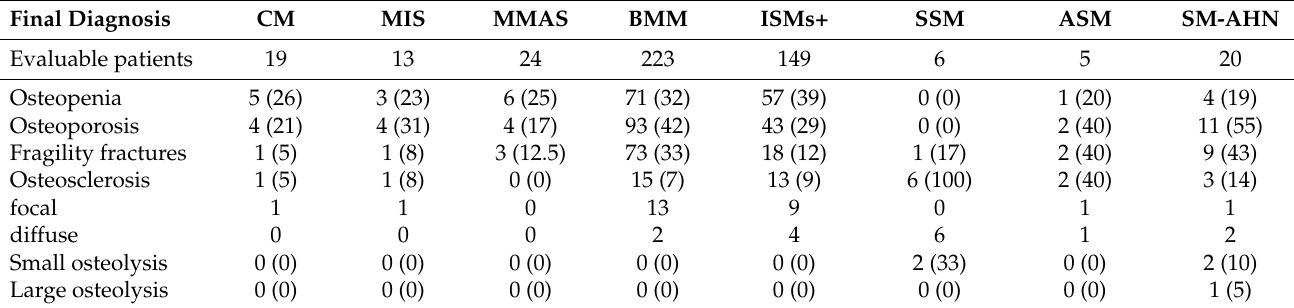
Table 5. Bone involvement in patients according to the diagnosis of clonal mast cell